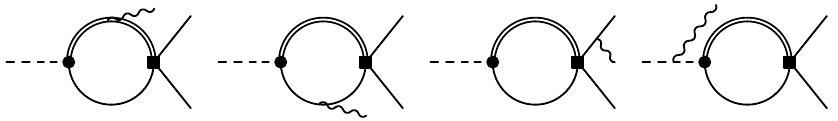
) in (3.5) (i.e. the radiative or real emission , p 2 B Φ B -particle. B